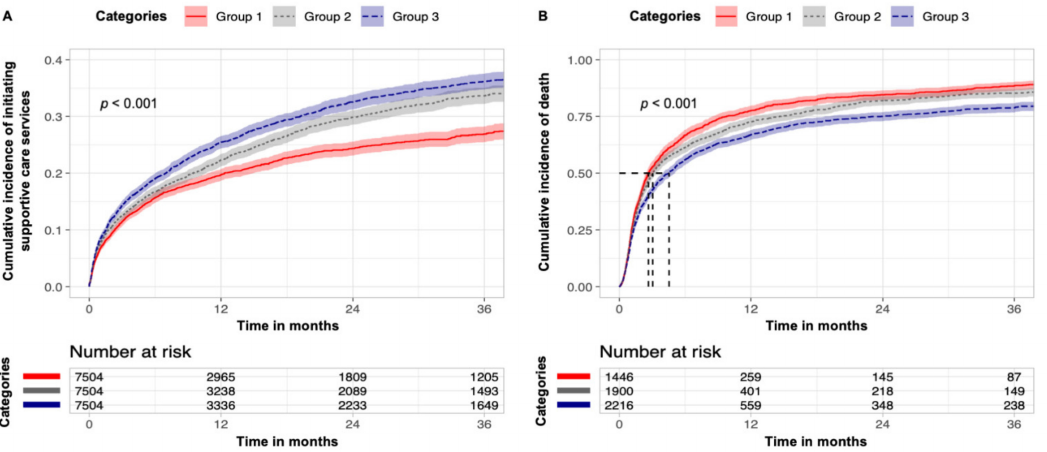
Figure 2. Timing of initiation of supportive care services . ( A ) Cumulative incidence of initiating supportive care services over time stratified by provider patient racial diversity index (provider pRDI) categories for the matched cohort. ( B ) Cumulative incidence of death following supportive care service initiation over time stratified by provider pRDI.